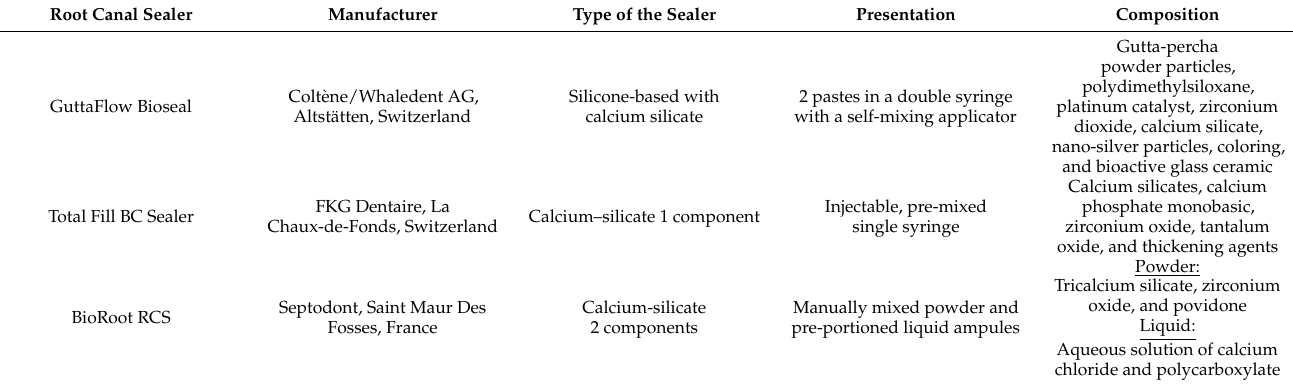
Table 1. Materials used in this